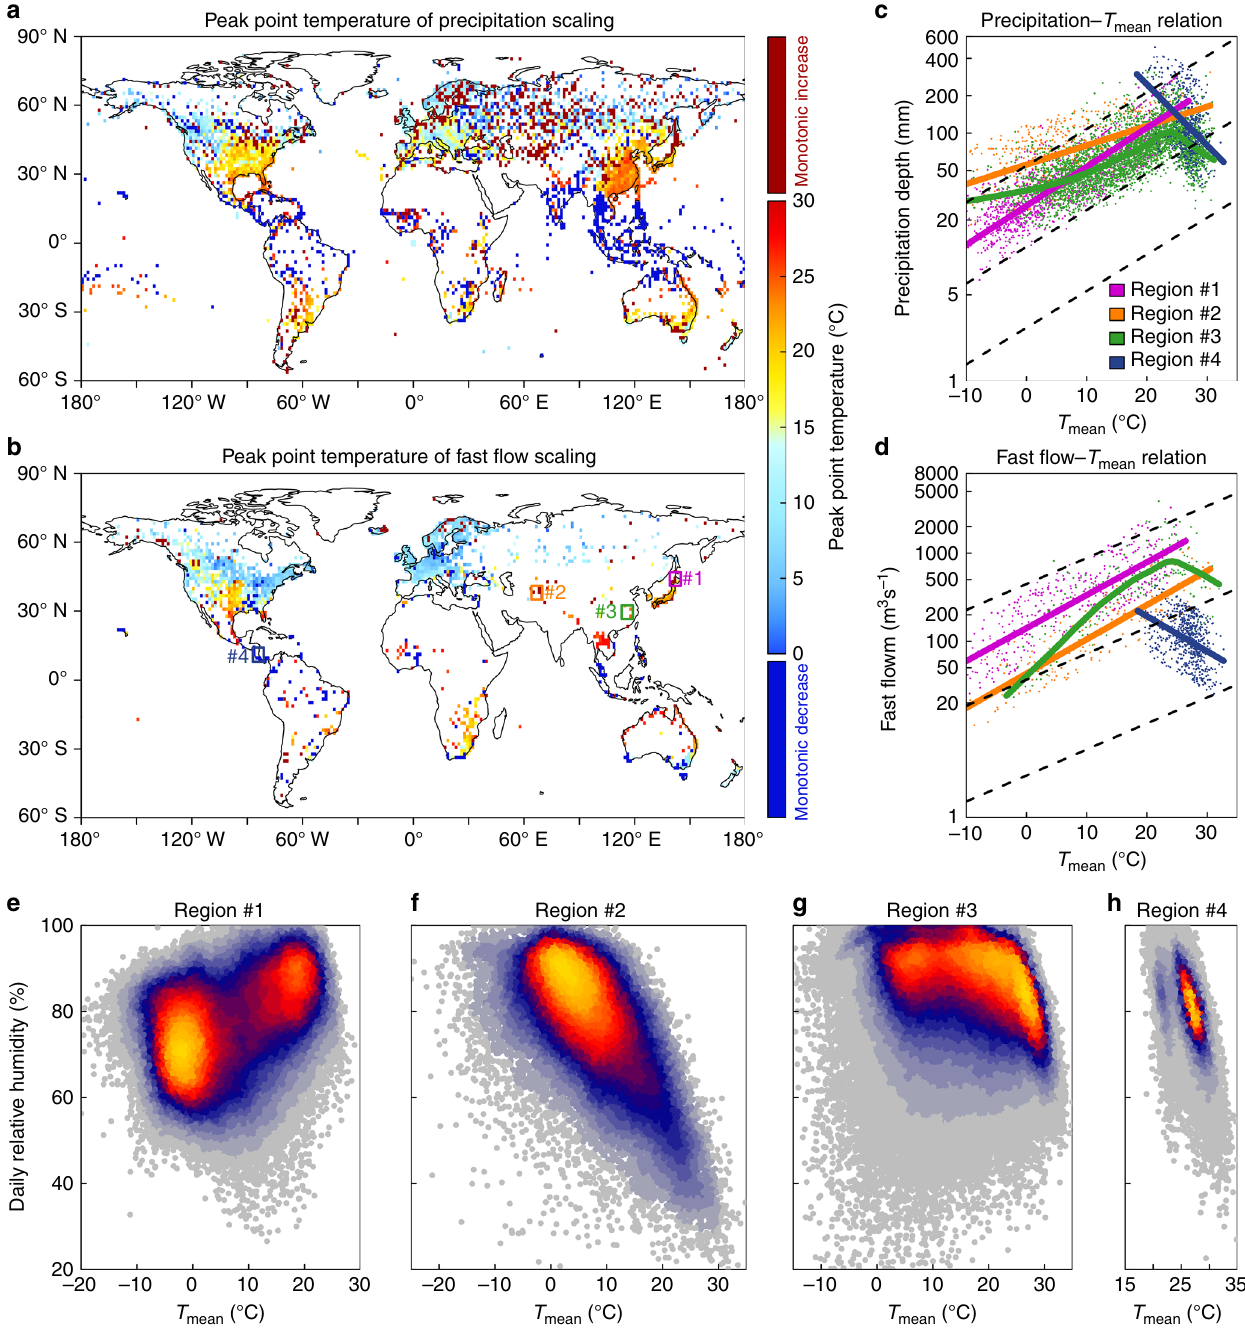
Fig. 2 Peak point temperature for percentile 99th extreme with daily mean temperature and extremes and relative humidity varying with temperature over four example regions. a , b Peak point temperature of precipitation extremes ( a ), and fast fl ow extremes ( b ). c , d Relationship between T mean with precipitation extremes ( c ), and fast fl ow extremes ( d ). e – h Relative humidity on wet day varying with T mean over four example regions, i.e., Region #1 ( e ), Region #2 ( f ), Region #3 ( g ) and Region #4 ( h ). Region #1 in north Japan (139°E – 145°E, 41°N – 47°N), Region #2 in western Asia (64°E – 70°E, 35° N – 41°N), Region #3 in southeastern China (113°E – 119°E, 27°N – 33°N) and Region #4 in Central America (81°W – 87°W, 8°N – 14°N). The solid curves in c , d are fi tted with extreme-temperature scatters using the LOWESS method, while the solid lines are fi tted by linear regression method ( p value < 0.05). Dashed lines are C – C